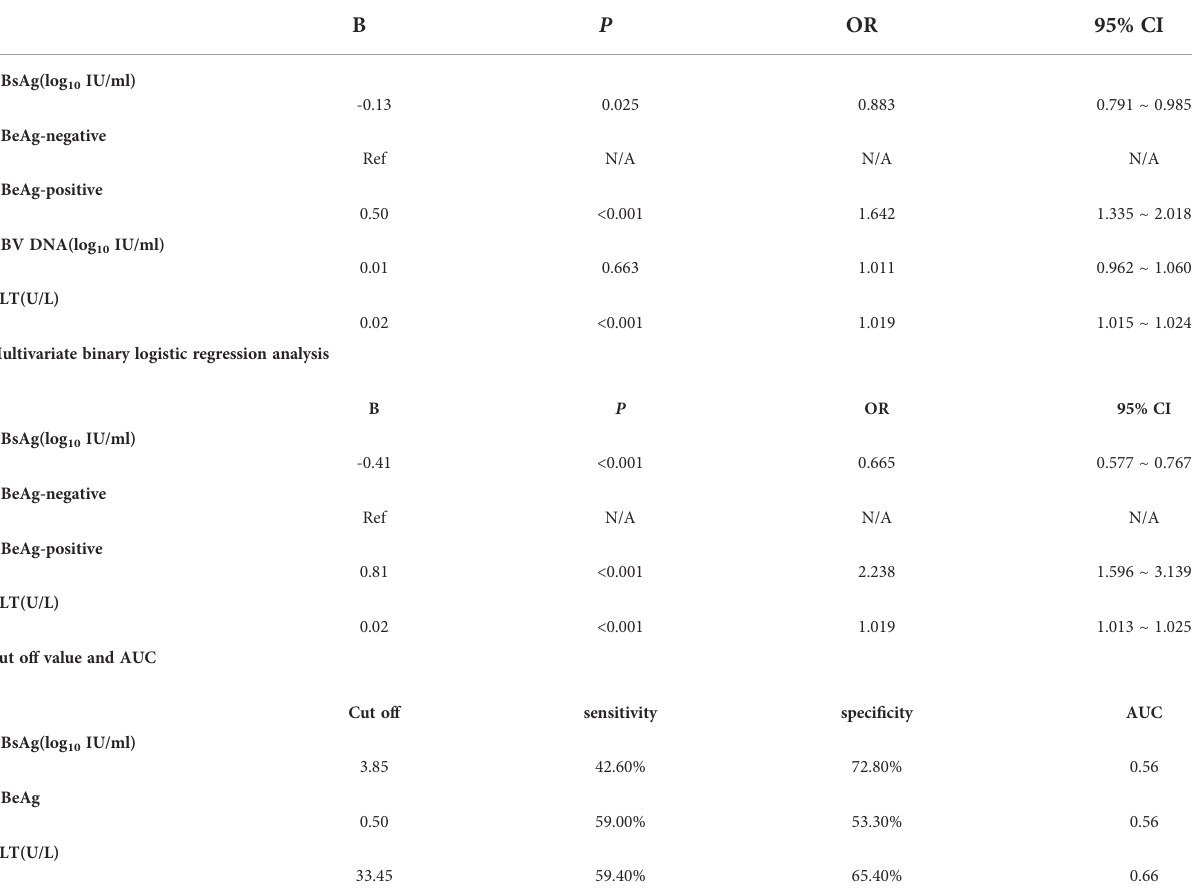
TABLE 4 Table of binary logistic regression analysis of overall patients regarding the occurrence of signi fi cant hepatic histopathology and cut off value for the variables. Univariate binary logistic regression